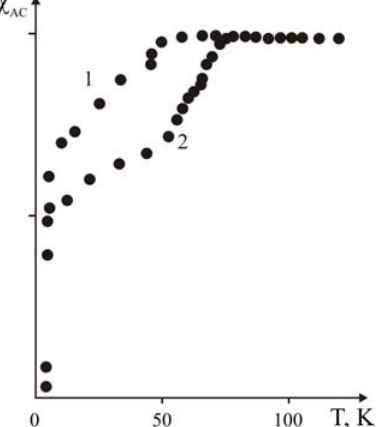
Figure 19. Dependence of the critical temperatures of transition into super conducting –T ) on the weight ratio of the ceramic and polyethylene, [21]. state and the width of (T c f